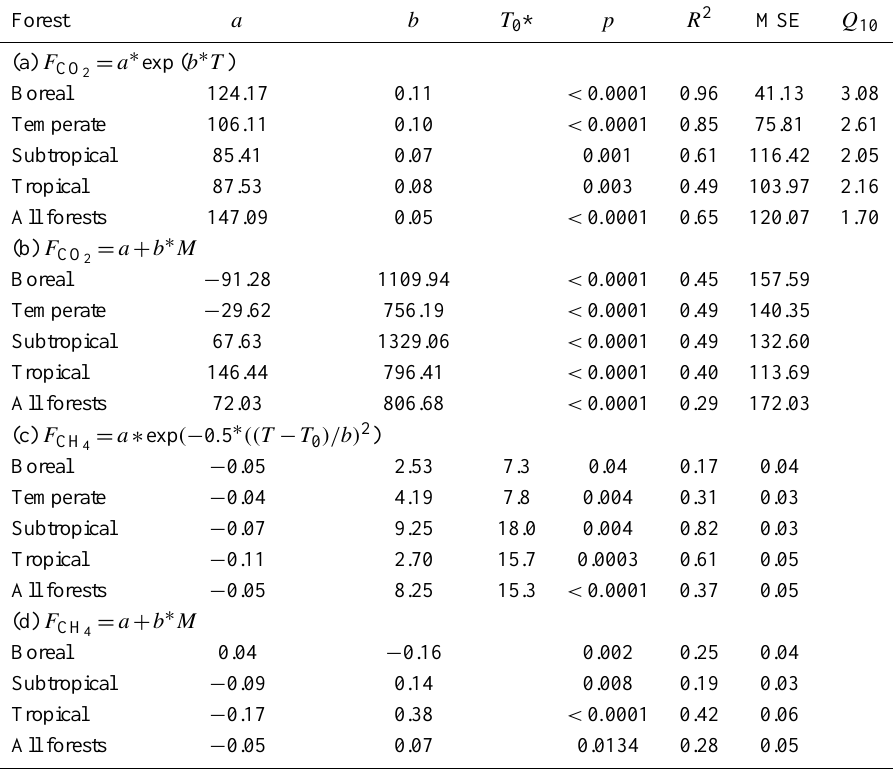
Table 3. Parameter values of the models for the relationship between the soil CO 2 and CH 4 fluxes and soil temperature ( T ) at a depth of 10cm and moisture ( M ) at the top 10cm soil layer.